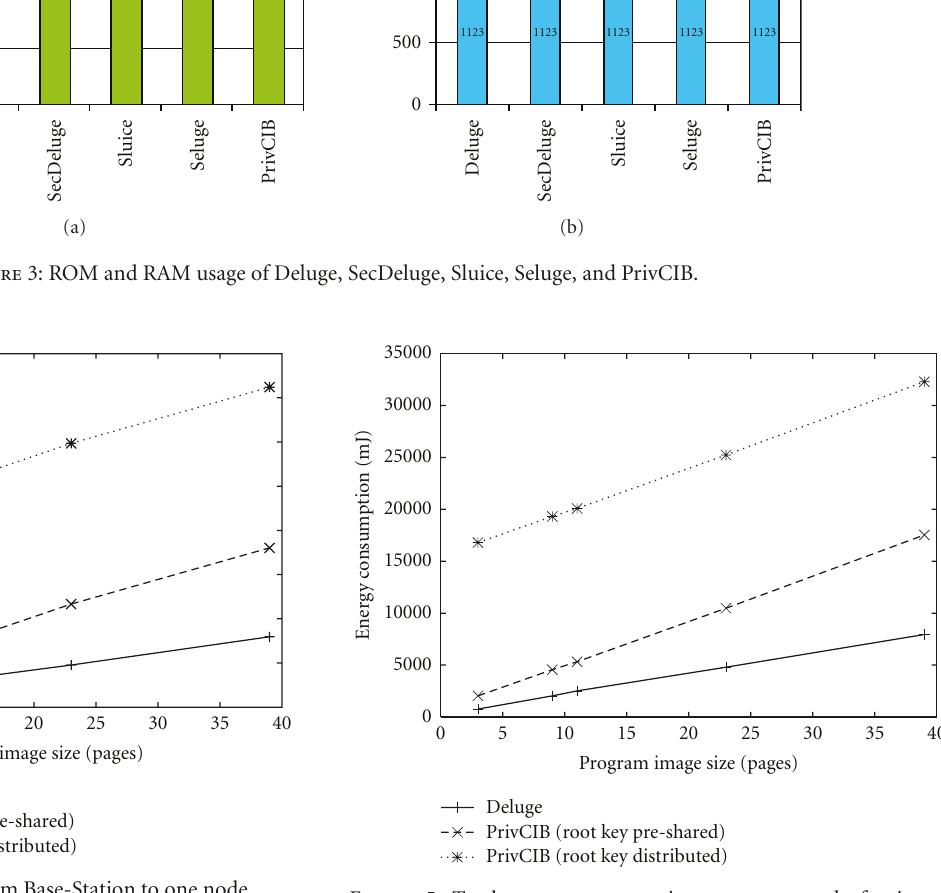
Figure 5: Total energy consumption on target node for image